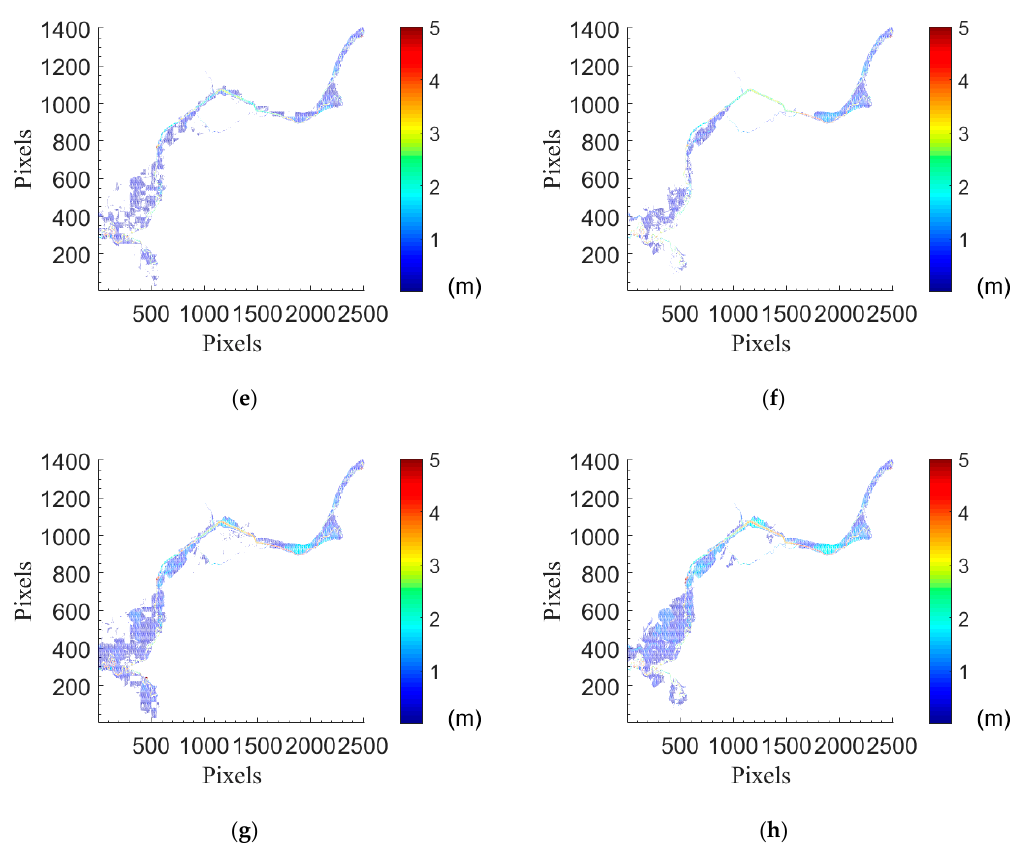
Figure 6. Inundation maps from the prediction of water depths of the first intervals in flood event 2006. ( a ) ANN inundation map 3 h; ( b ) hydrodynamic inundation map 3 h; ( c ) ANN inundation map 6 h; ( d ) hydrodynamic inundation map 6 h; ( e ) ANN inundation map 9 h; ( f ) hydrodynamic inundation map 9 h; ( g ) ANN inundation map 12 h; ( h ) hydrodynamic inundation map 12 h. Table 2. Numbers of wet grids and accurate grid percentage for event 2006. A wet grid is with the water level over 0.1 m; any water depth below this cutoff value is eliminated. Table shows grid numbers with a larger root-mean-square error (RMSE) and their percentages to the total wet grids. Prediction Time (h) 405 84